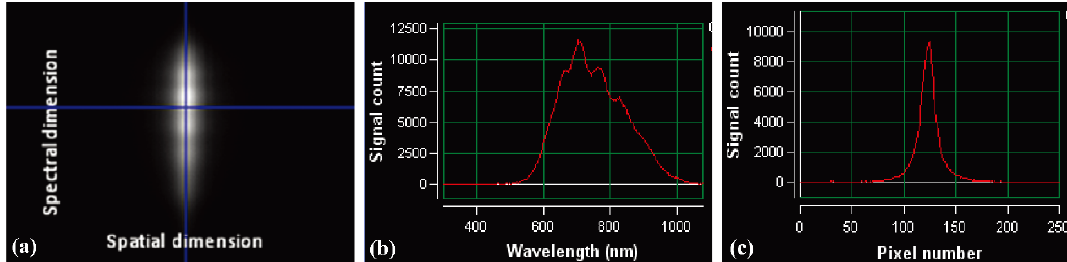
Figure 22. ( a ) A hyperspectral scattering image of a peach sample; ( b ) a reflectance spectrum corresponding to the vertical line in ( a ); and ( c ) a spatially-resolved reflectance profile corresponding to the horizontal line ( a ).